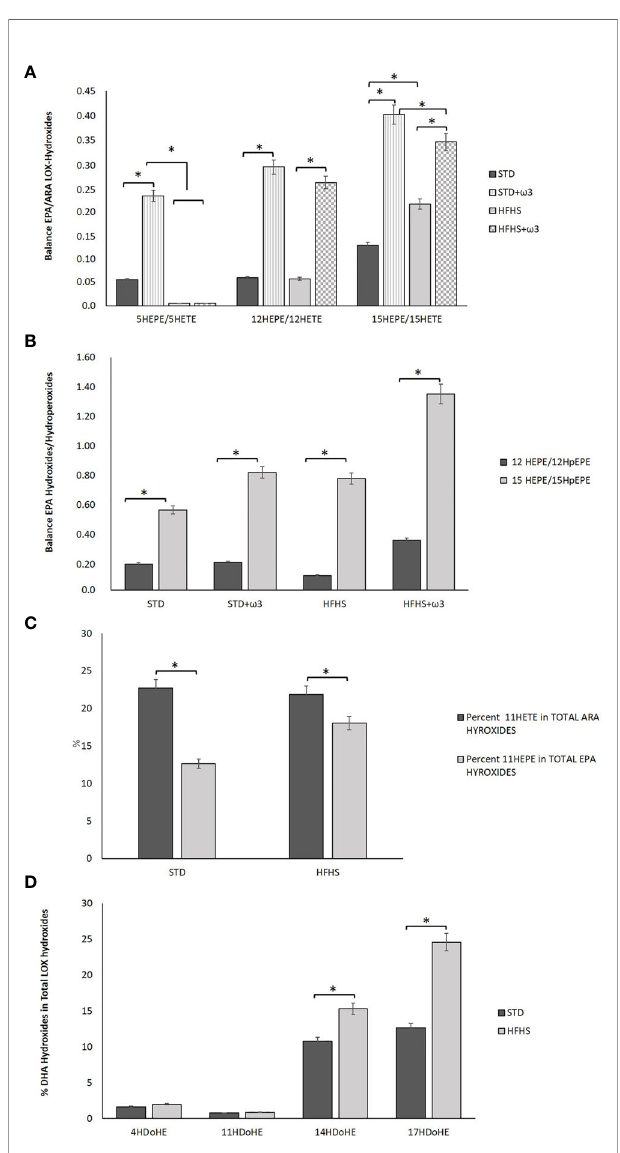
FIGURE 1 | Comparison of lipid mediators formed in the perigonal adipose tissue of rats fed STD, STD+ w 3, HFHS or HFHS+ w 3 diets. (A) . Balance of several EPA/ARA LOX-Hydroxides, particularly, 5HEPE/5HETE, 12HEPE/ 12HETE and 15HEPE/15HETE measured in adipose tissue from rats fed STD, STD+ w 3, HFHS or HFHS+ w 3 diets. (B) . Balance of several Hydroxides/ Hydroperoxides from EPA, particularly 12HEPE/12HpHEPE and